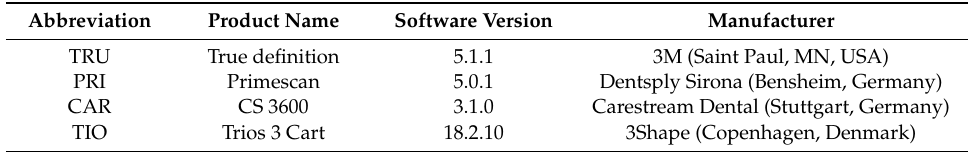
Figure 3. Schematic drawing of the classification system by Nordland and Tarnow [35] to describe the dimension of interdental areas (facial cemento-enamel junction (CEJ, A), interproximal CEJ (B), interdental contact point (C)). Table 2. Intraoral scanners used in this